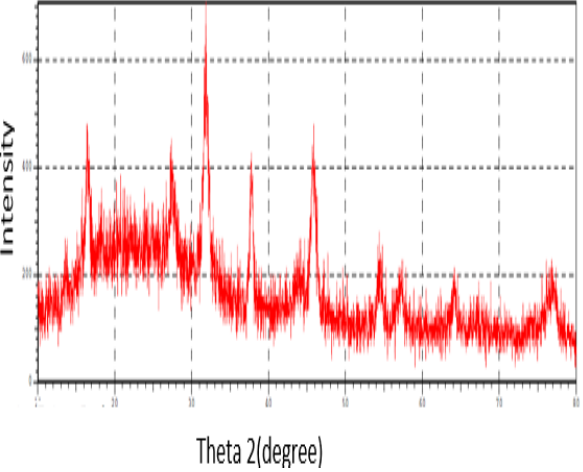
Figure 3. X-ray diffraction pattern for Nigella sativa seeds silver nanoparticles made from AgNO Nigella sativa extract in pH 5.5